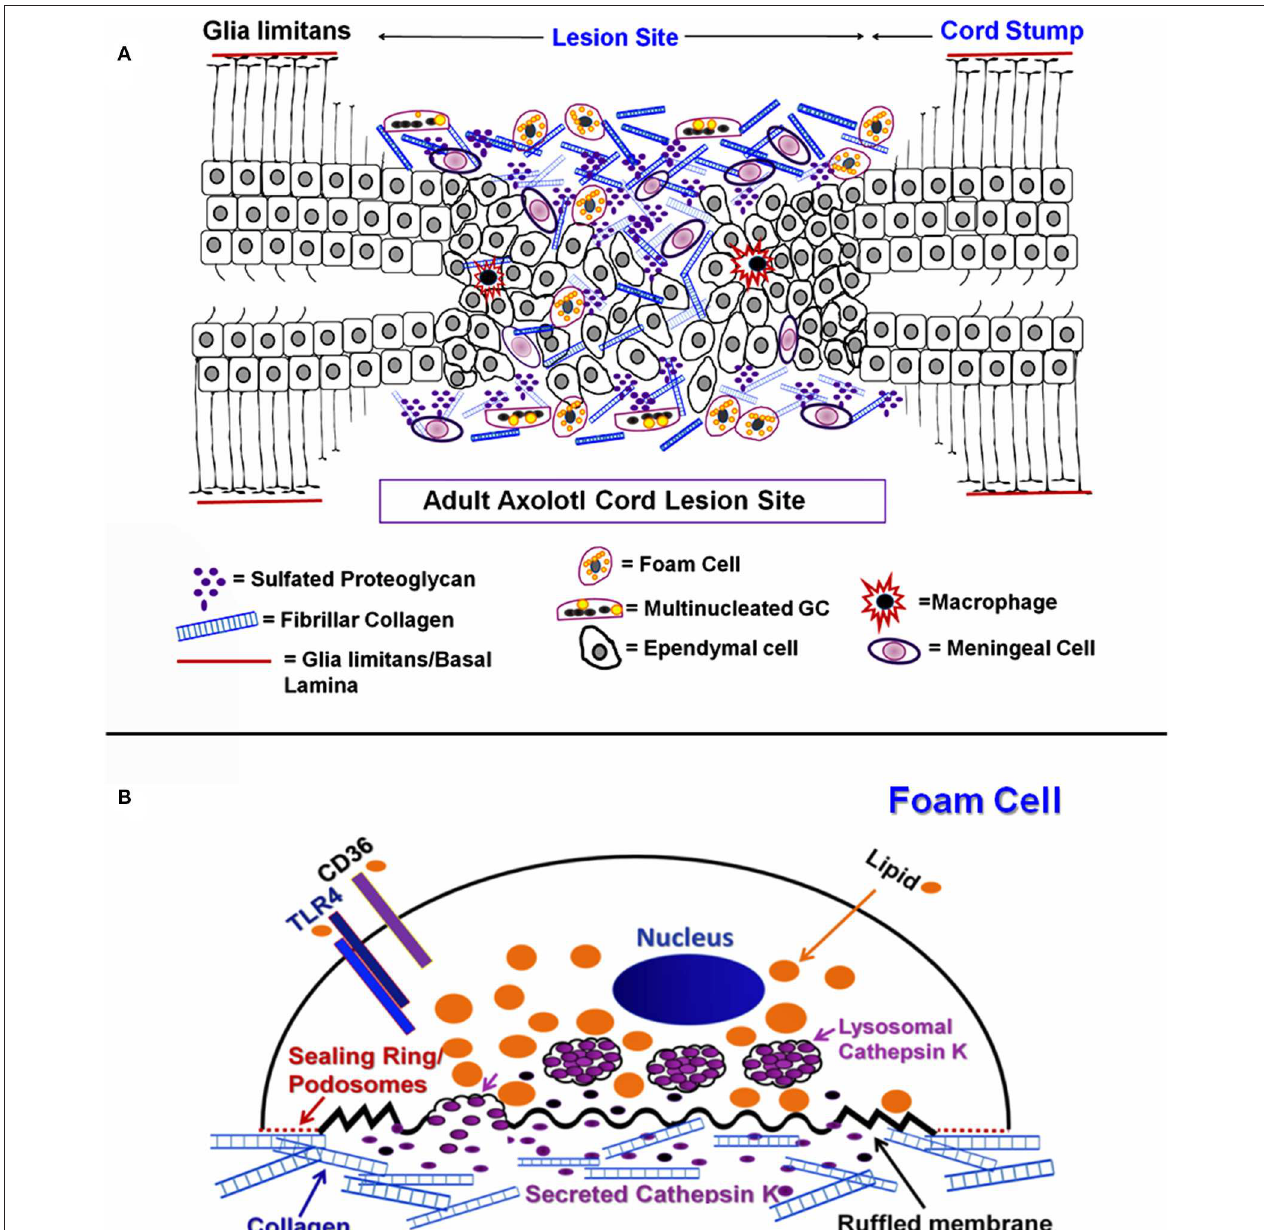
FIGURE 15 | Diagram of ECM and cellular associations in regenerating cord. (A) Diagrammatic representation of mesenchymal ependymal cell outgrowth and meningeal invasion gap regeneration of the Axolotl cord lesion site. Ependymal cells, foam cells, MNGCs, macrophages and meningeal cells are shown within extracellular matrix. Neurons and oligodendrocytes are not represented. (B) Diagrammatic representation of a foamy macrophage producing cathepsin